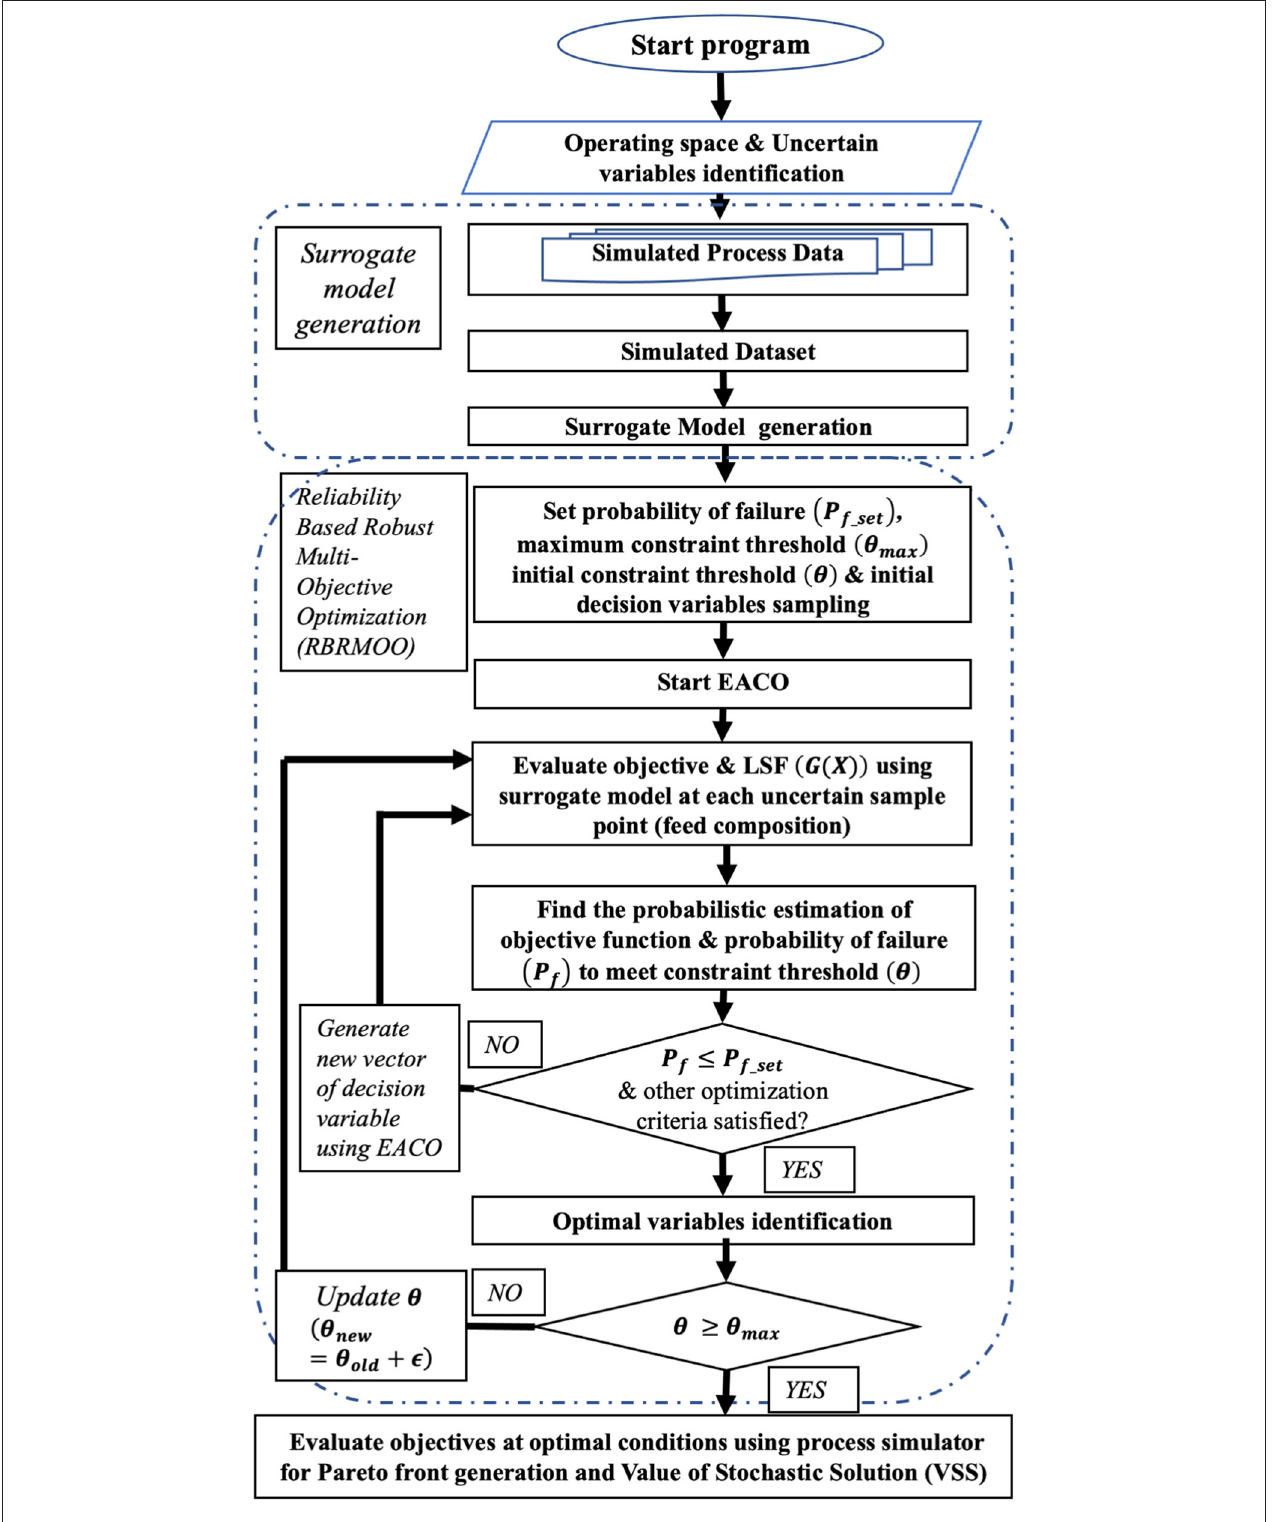
FIGURE 4 | Algorithmic flow diagram for optimization of natural gas dehydration process with RBRMOO method.